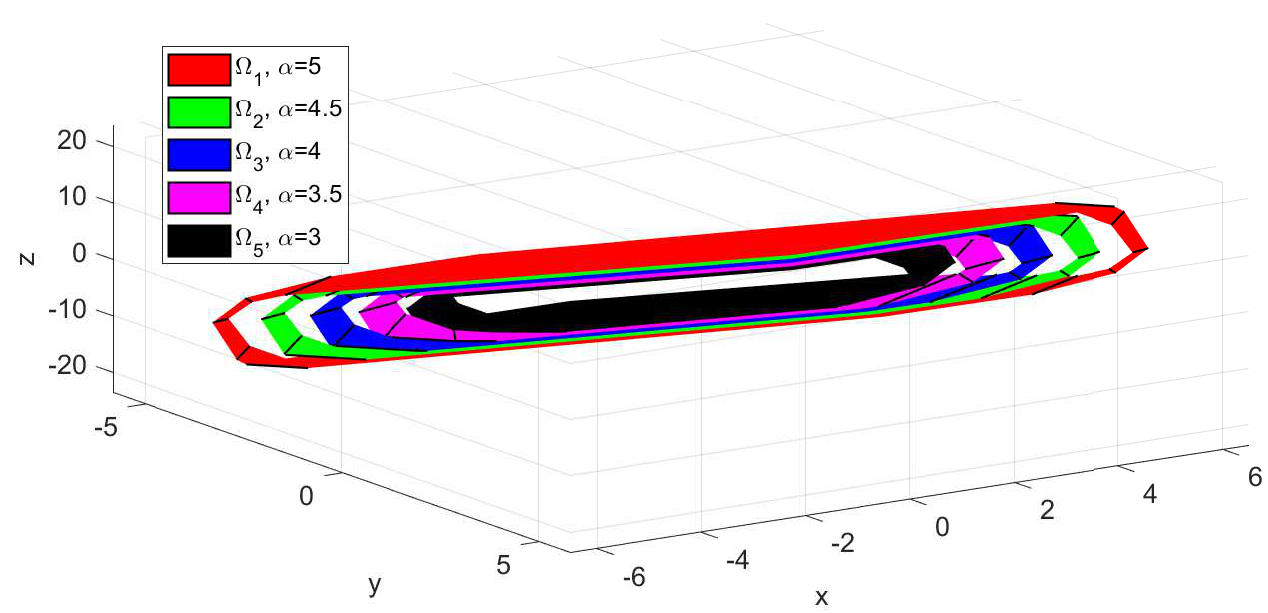
Figure 2. Depiction of the predefined invariant sets corresponding to sub-system S 1, computed for uncertainty constraint limit value β = 0.1.